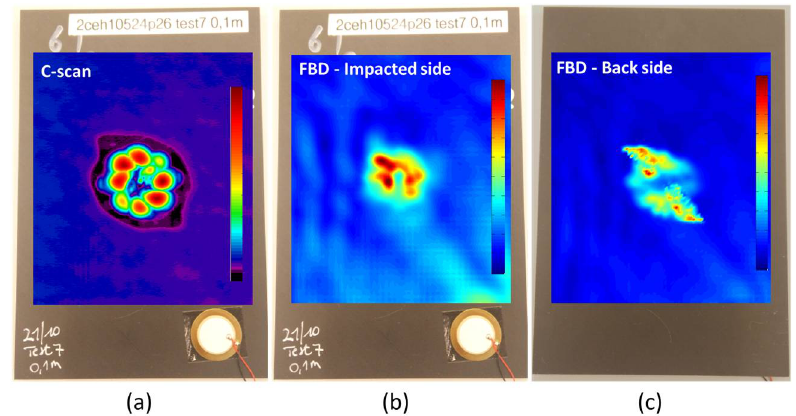
Figure 3. Picture with ultrasonic C-scan in reflection mode at 5 MHz ( a ) and frequency band data (FBD) over entire excitation bandwidth for broadband vibrometric inspection of a CFRP coupon with BVID from the impacted ( b ) and the back ( c )